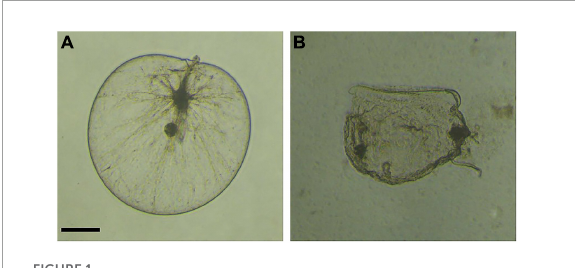
FIGURE1 Microscope images of Noctiluca scintillans when co-incubated with strain LD-B6 at (A) 0 h, (B) 12 h. Scale bars = 100 µ